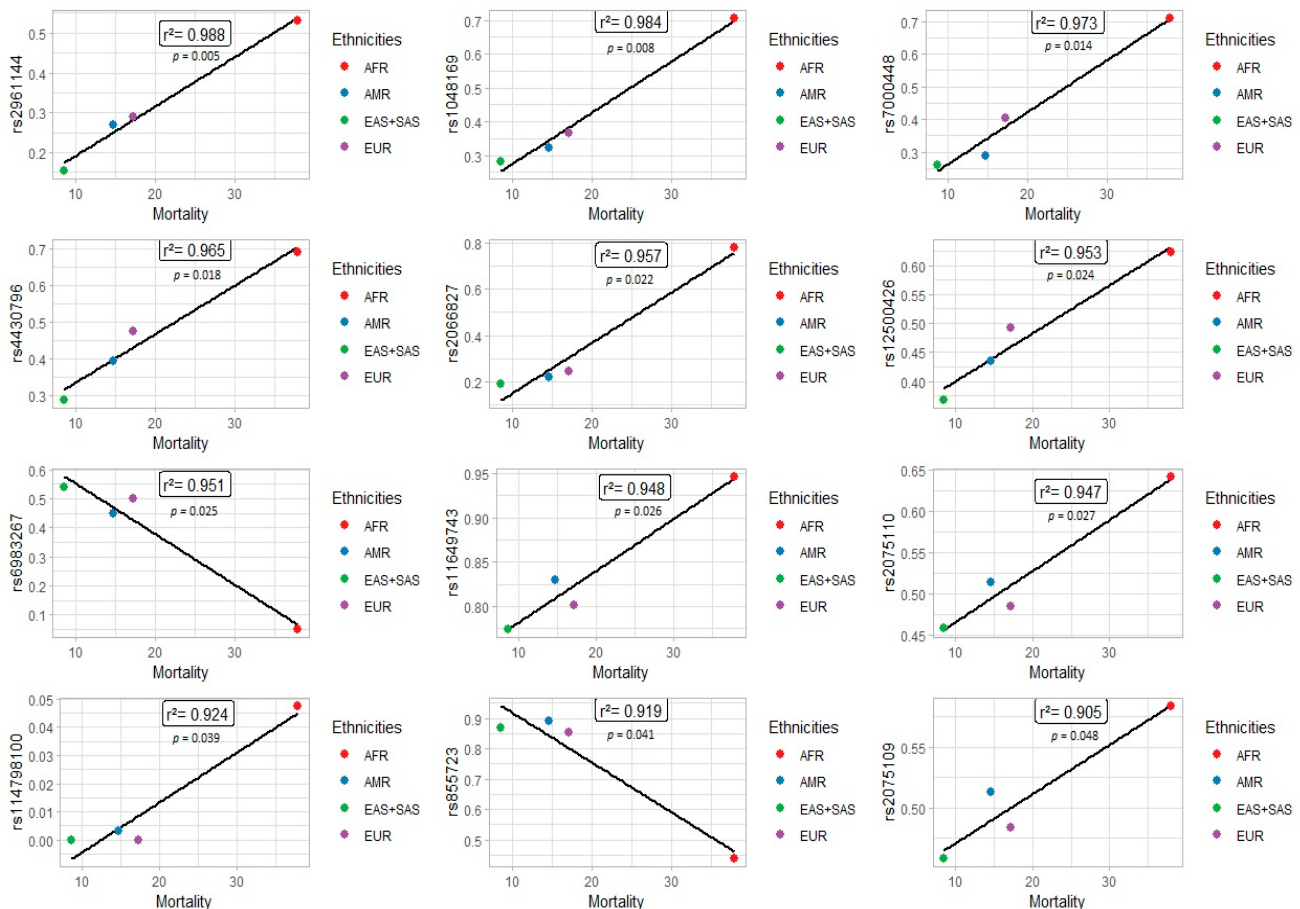
Figure 3. SNPs associated with prostate cancer mortality in different populations.